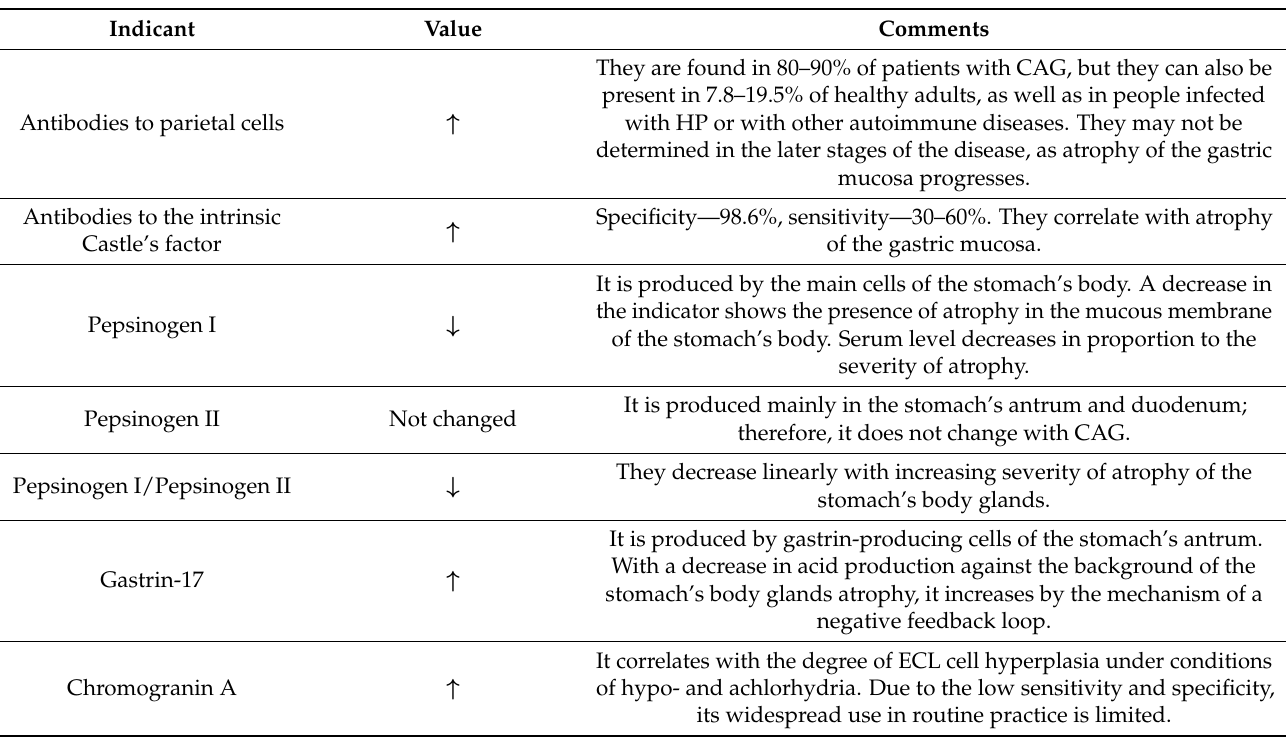
Table 4. Laboratory markers of